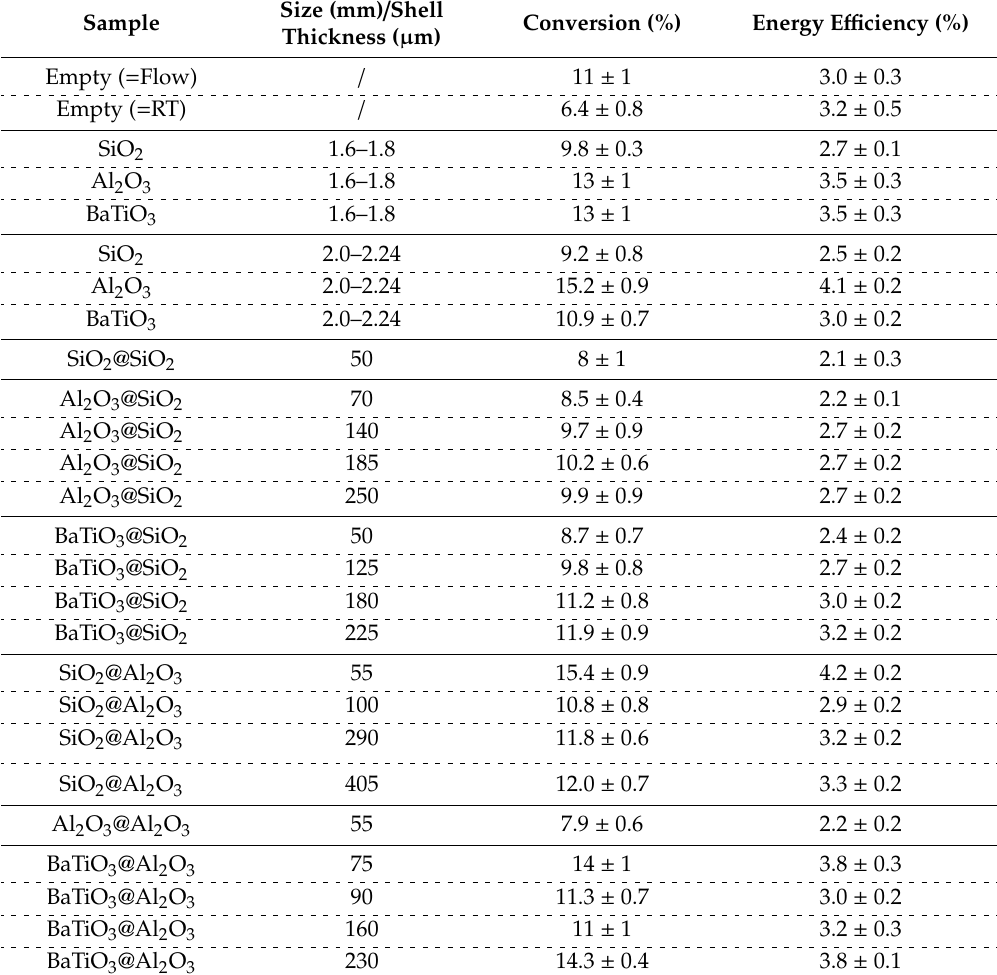
Table A1. Conversion and energy e ffi ciency of (i) the empty DBD reactor, both at the same flow rate and residence time (RT) as the packed bed reactor, and (ii) of all samples used in this work (including pure uncoated spheres and the various combinations of core-shell spheres) as shown in Figures 1 and 2.